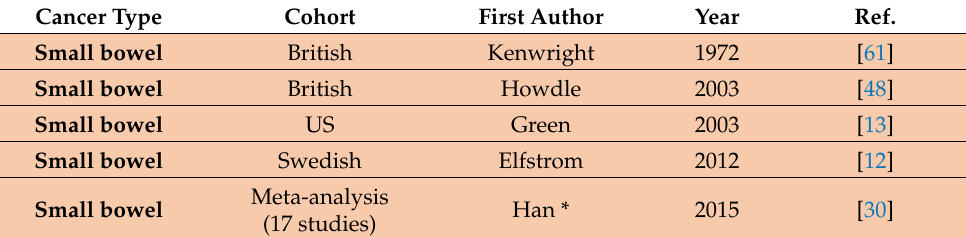
Table 4. Studies examining small bowel carcinoma risk in CD